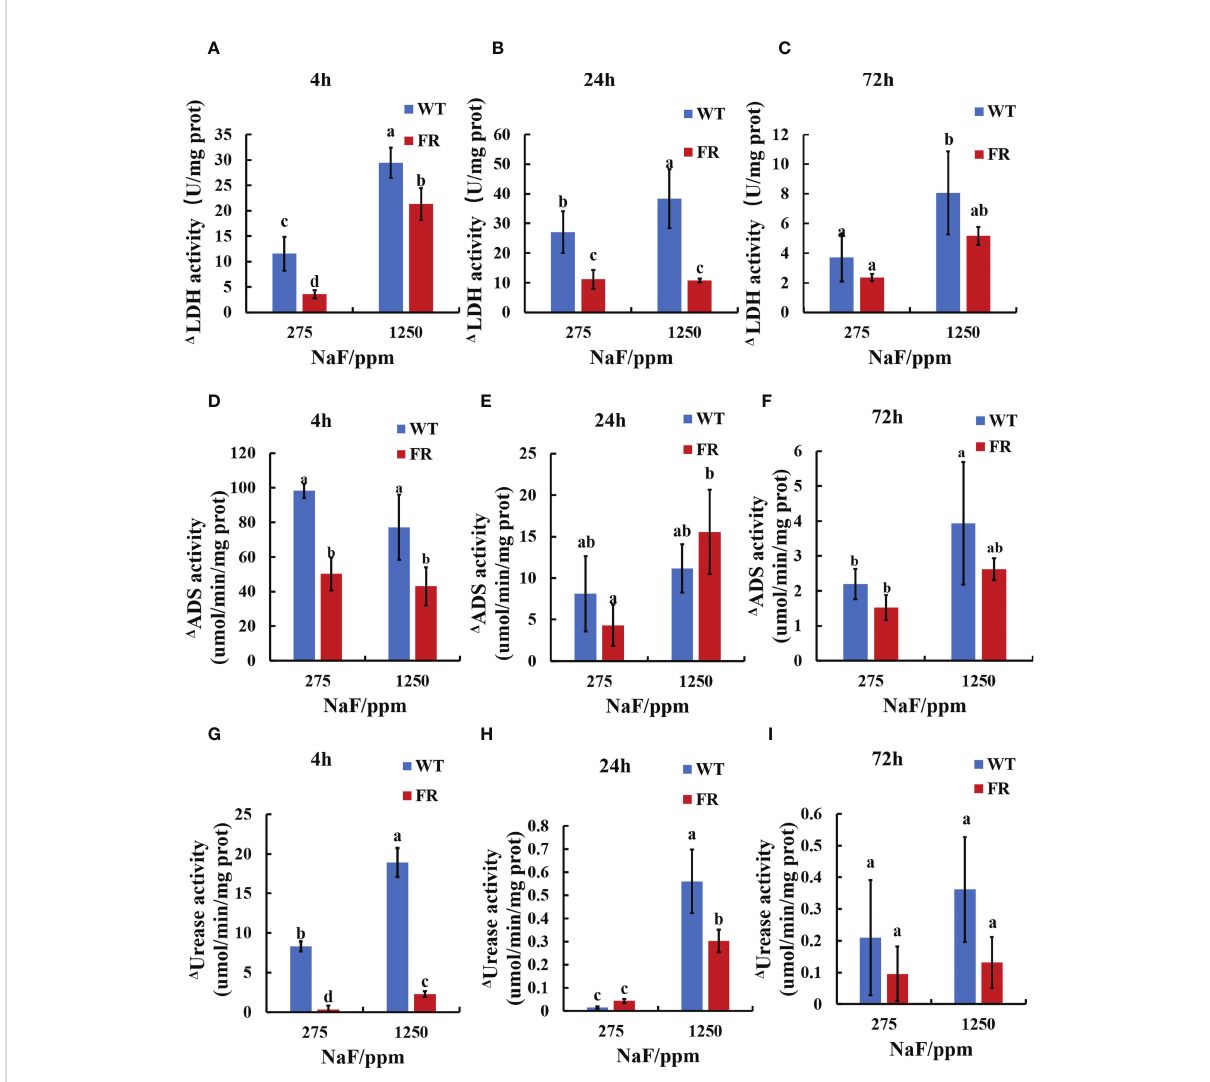
FIGURE 3 Enzyme activity in bio fi lms. (A-C) LDH activity. (D-F) ADS activity. (G-I) Urease activity. D represents shape of the absolute value of deviation of enzyme activities when compared with corresponding 0 ppm. Data are presented as mean ± standard deviation, and different letters demonstrate a signi fi cant difference between groups (P <